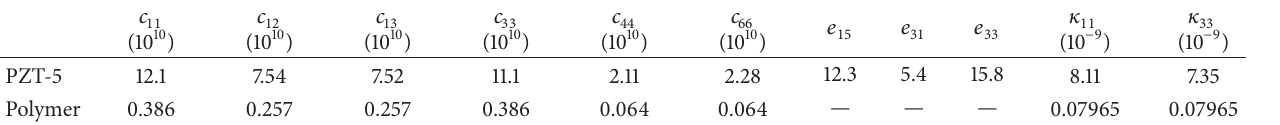
Figure 1: (a) Schematic diagrams of periodic 1–3 composite laminate and (b) unit cell (the fibre laminates are poled in 𝑥 3 direction) [16]. Table 1: Composite constituent’s properties